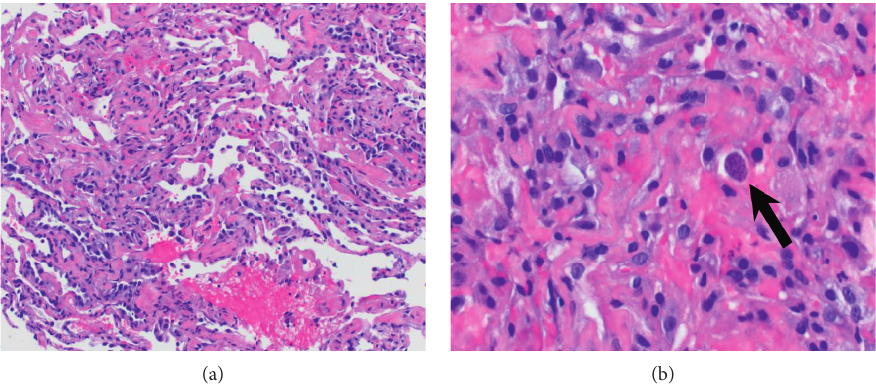
Figure 3: (a, b) Hematoxylin and eosin stain showed thickening of respiratory membrane and increase type II pneumatocytes. High-power view showed a cyst containing discrete granule-type bradyzoites in lung parenchyma (arrow).